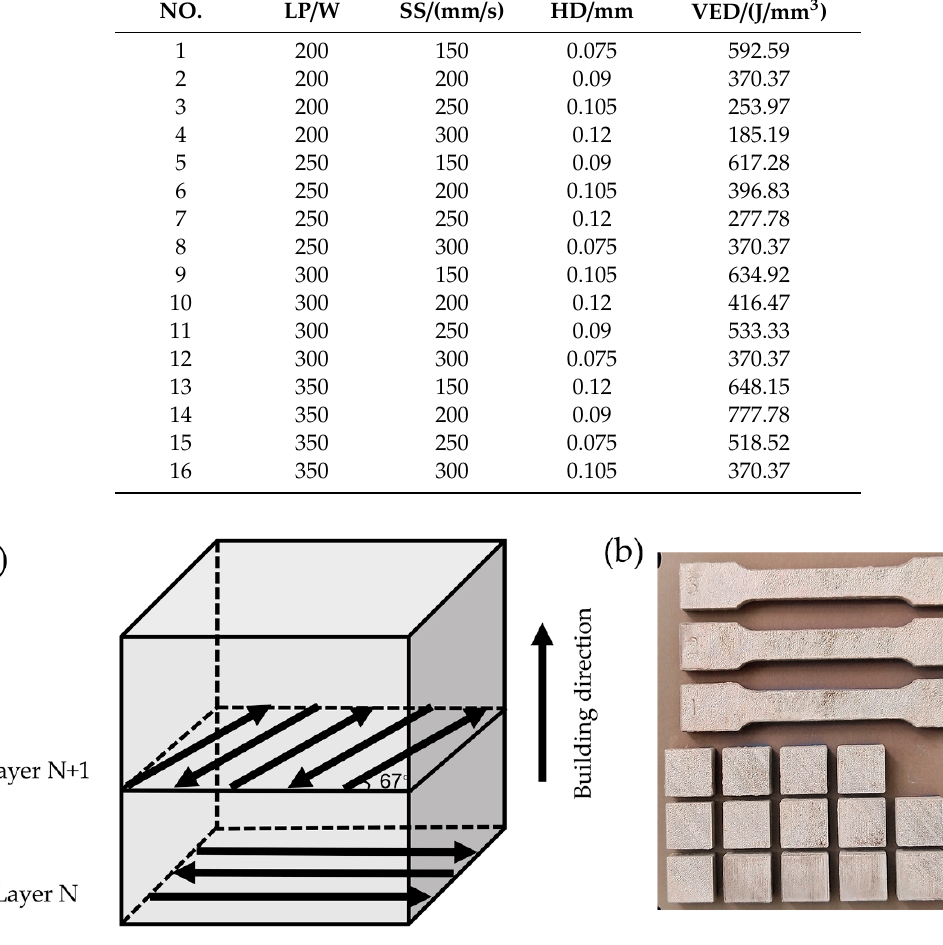
Figure 4. ( a ) Scan strategy used in this experiment; ( b ) 90W ‐ 7Ni ‐ 3Fe samples fabricated by the designed process parameters.